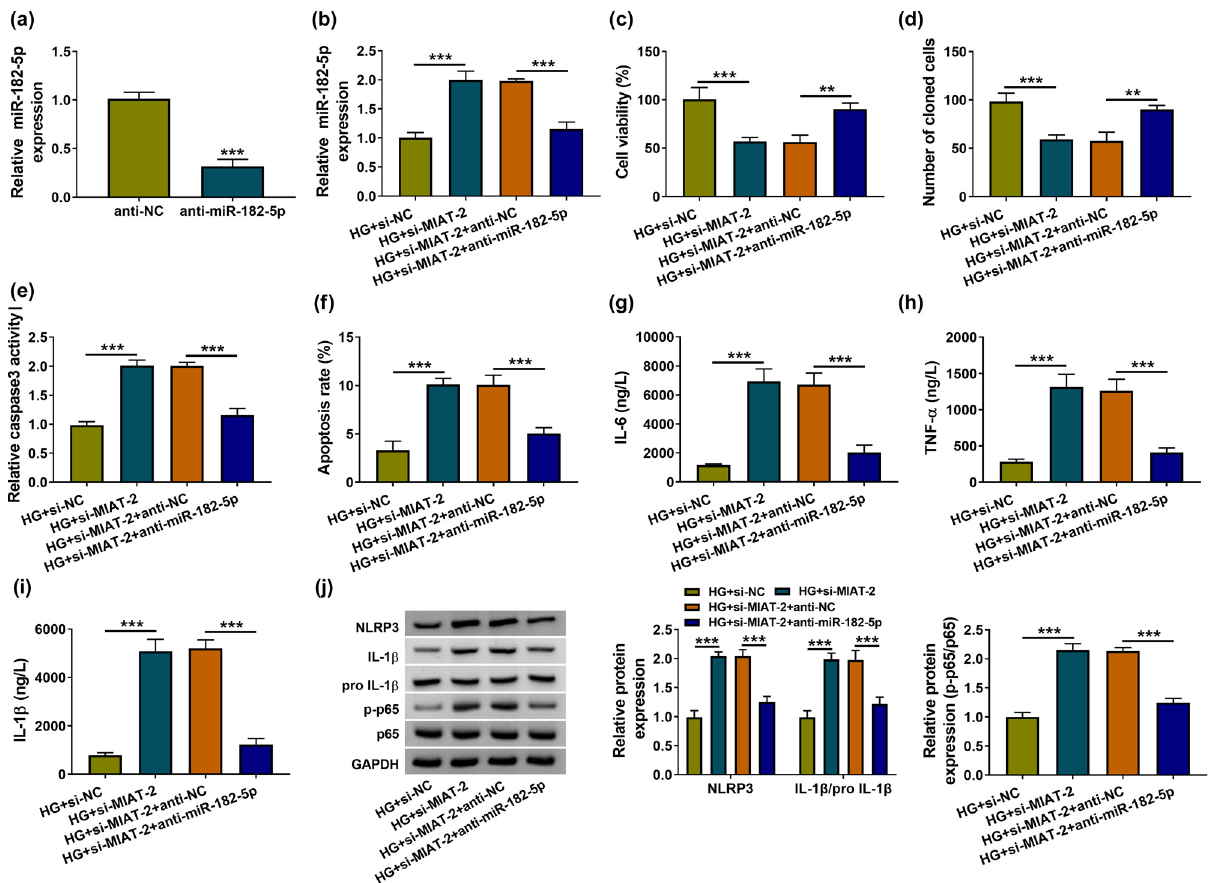
Figure 4: Knockdown of MIAT promoted the HG - induced cell e ff ects and NF - κ B signal by upregulating the miR - 182 - 5p level. ( a ) The in fl uence of anti - miR - 182 - 5p on miR - 182 - 5p was assessed by RT - qPCR. ( b ) After co - treatment of HG + si - NC, HG + si - MIAT - 2, HG + si - MIAT - 2 + anti - NC, or HG + si - MIAT - 2 + anti - miR - 182 - 5p, RT - qPCR was performed for examining the expression of miR - 182 - 5p. ( c – f ) The analyses of cell viability ( c ) , colony formation ( d ) , and apoptosis ( e – f ) were completed by implementing CCK - 8, colony formation assay, and caspase - 3 assay/ fl ow cytometry. ( g – i ) In fl ammatory cytokines were measured via ELISA. ( j ) The in fl ammation and NF - κ B associated proteins were determined via western blot. ** P < 0.01, *** P <